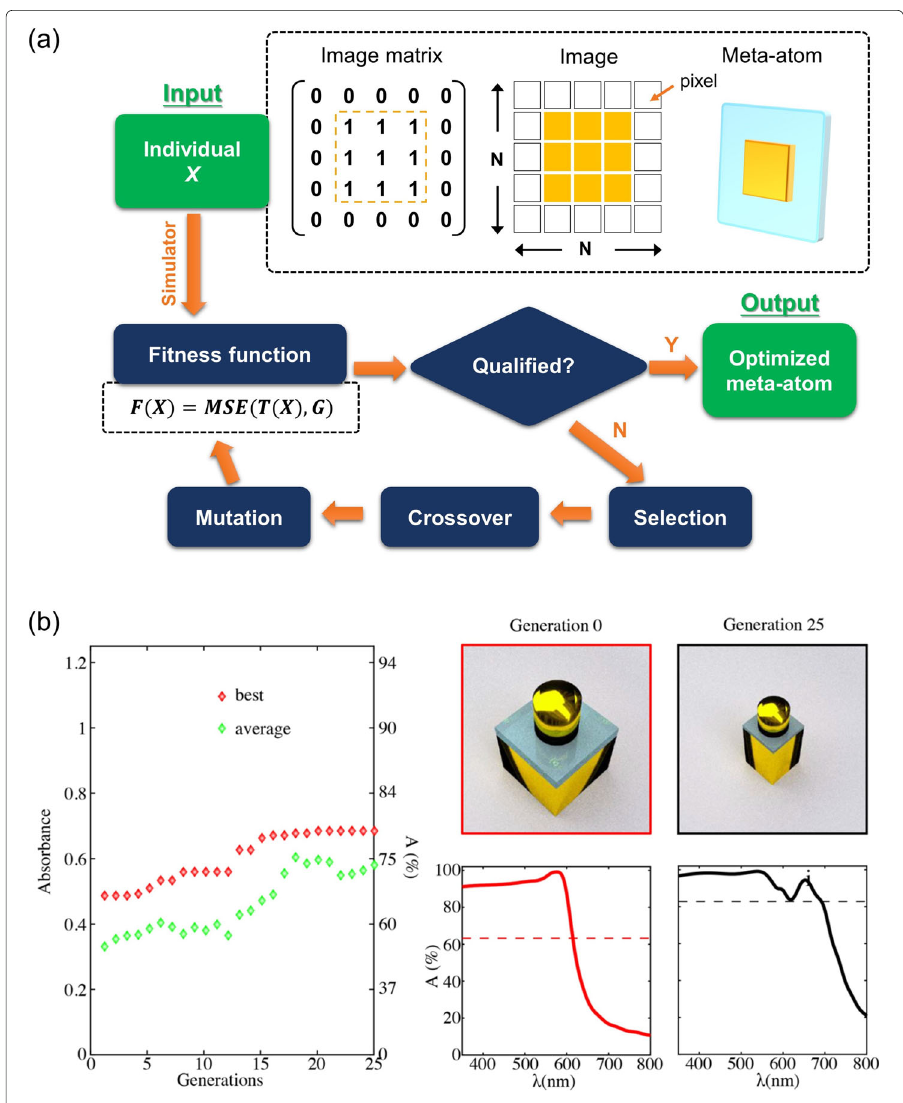
Fig. 3 GA for meta-atoms spectral modifications. (a) The working flowchart of GA. Here the spatial distribution of meta-atom in a unit cell is processed as a binary matrix (referred as an individual X ) for the evaluation of a fitness function F ( X ) . (b) GA-based prominent enhancement of broadband absorbances arising from gold nanoparticles. Left: the optimization process with the best value (red diamonds) and averaged value (green diamonds) of fitness scores ¯ A . After 25 generations the best value approaches 0.792, being equal to a spectral (from 350 to 800 nm) averaged absorption of 79.2%. Right: two best structure arrangements (upper) with their spectral behaviors (lower) at initial (red framed) and ultimate (black framed) generations, respectively. Figure reproduced with permission: (b) Ref. [29], Copyright 2020